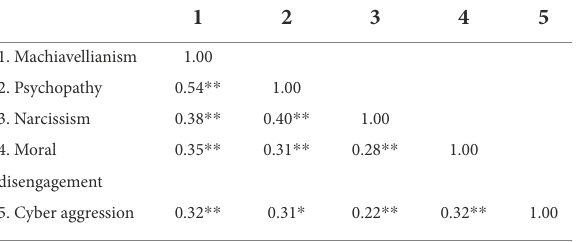
TABLE 2 Bivariate correlations matrix of all variables ( N = 501).